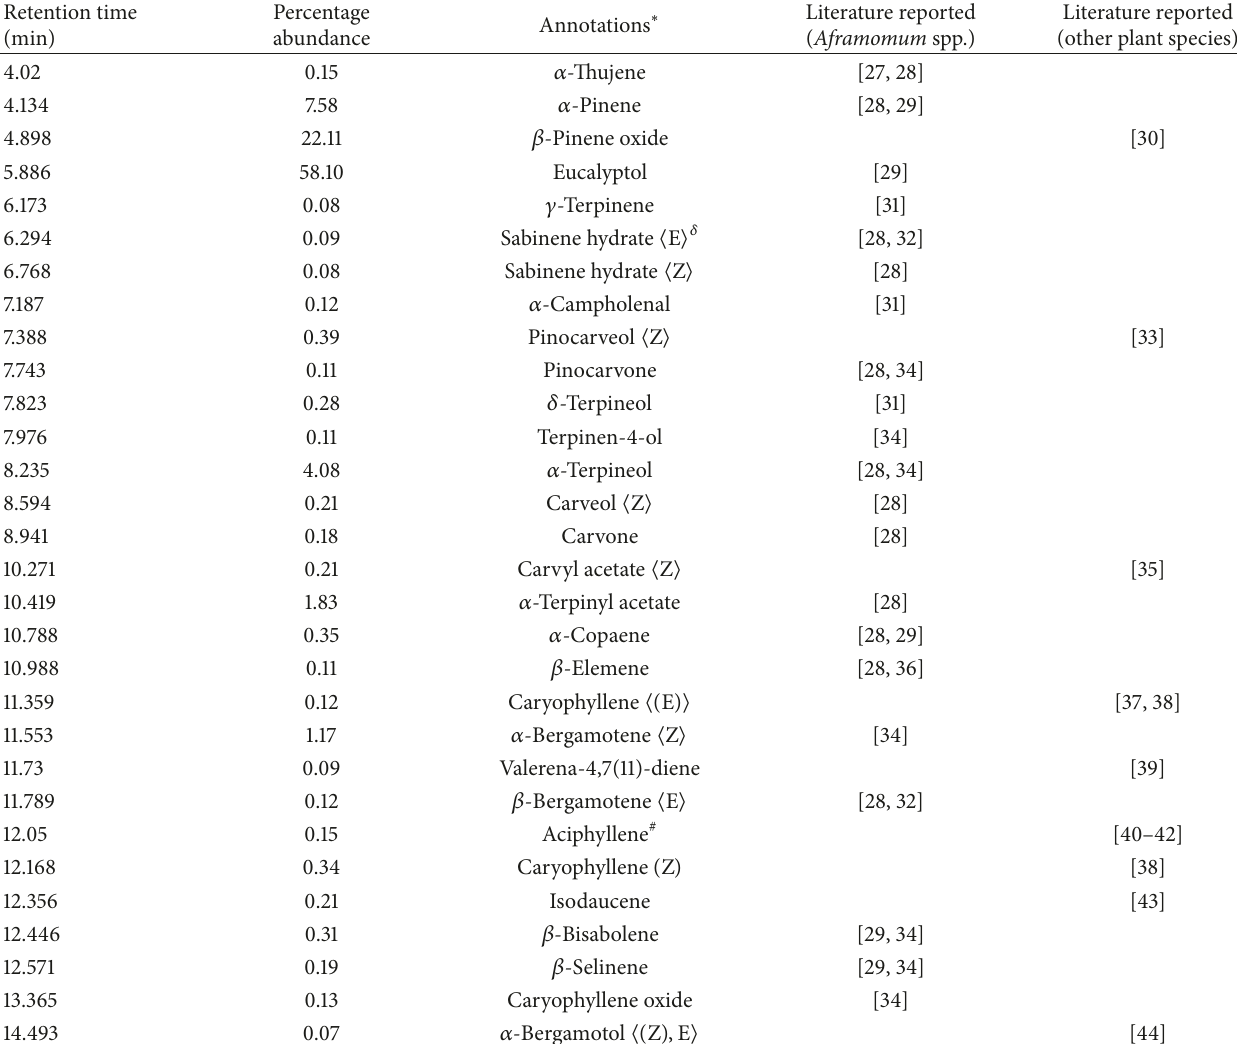
Table 2: Top 30 most abundant VOCs extracted from A. danielli seeds annotated using the three libraries listed in Table 1. Retention